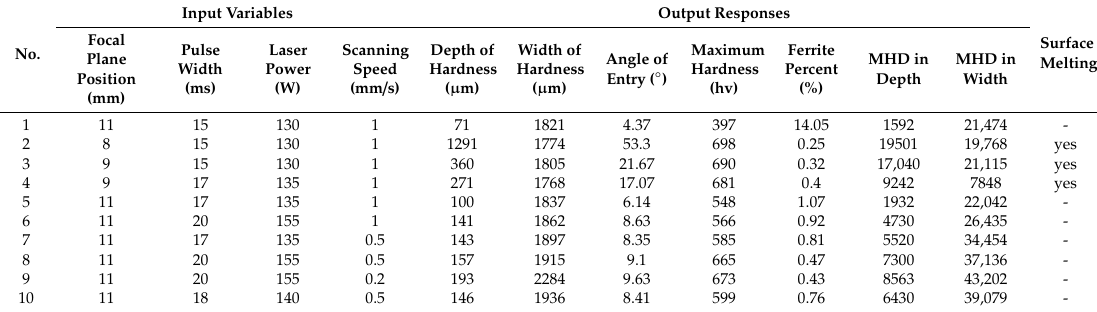
Table 2. Experimental setting and results of laser surface hardening by Nd:YAG